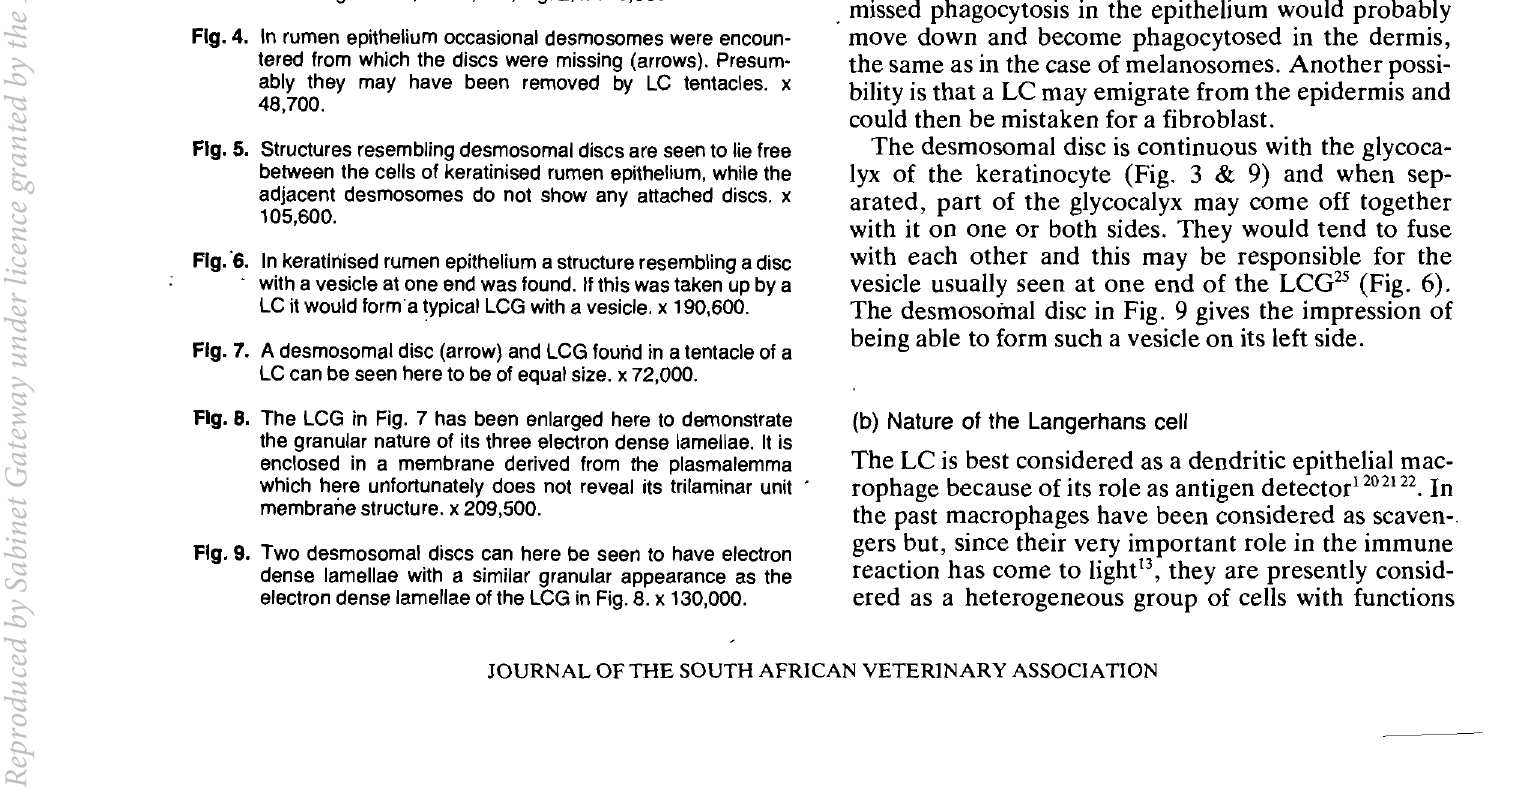
Fig. 4. In rumen epithelium occasional desmosomes were encoun tered from which the discs were missing (arrows). Presum ably they may have been removed by LC tentacles. x 48,700. Fig. 5. Structures resembling desmosomal discs are seen to lie free between the cells of keratinised rumen epithelium, while the adjacent desmosomes do not show any attached discs. x 105,600. Fig. ·6. In keratihised rumen epithelium a structure resembling a disc . with a vesicle at one end was found. If this was taken up by a LC it would forma typical LCG with a vesicle. x 190,600. Fig. 7. A desmosomal disc (arrow) and LCG found in a tentacle of a LC can be seen here to be of equal size. x 72,000. Fig. 8. The LCG in Fig. 7 has been enlarged here to demonstrate the granular nature of its three electron dense lamellae. It is enclosed in a membrane derived from the plasmalemma which here unfortunately does not reveal its trilaminar unit . membrane structure. x 209,500. Fig. 9. Two desmosomal discs can here be seen to have electron dense lamellae with a similar granular appearance as the electron dense lamellae of the LCG in Fig. 8. x